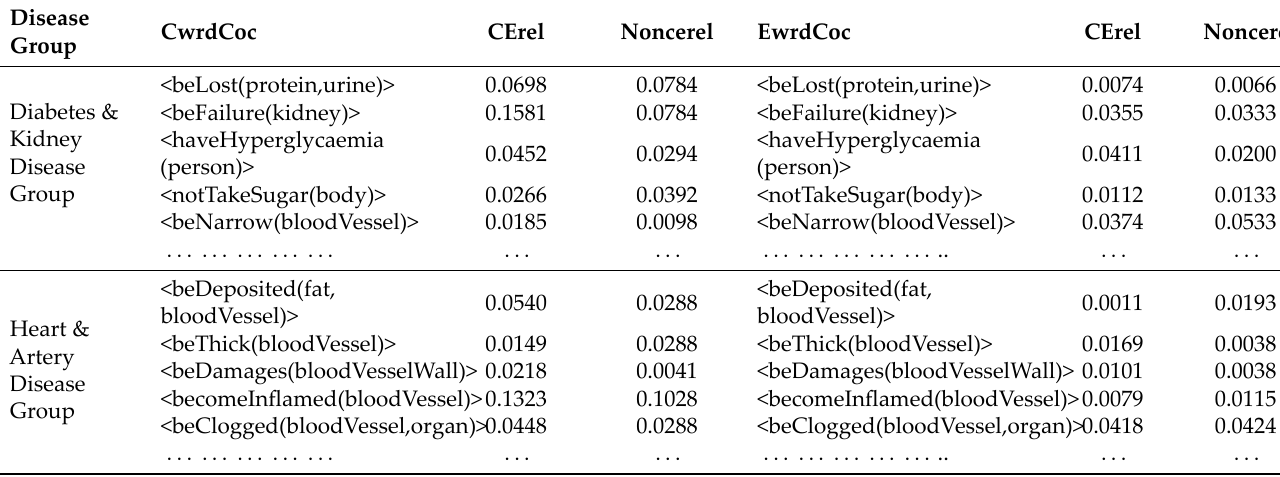
Table 2. Show the CErel and nonCErel probabilities of CwrdCoc features and EwrdCoc features in wrdCoc pairs of the diabetes and kidney disease group and the heart and artery disease